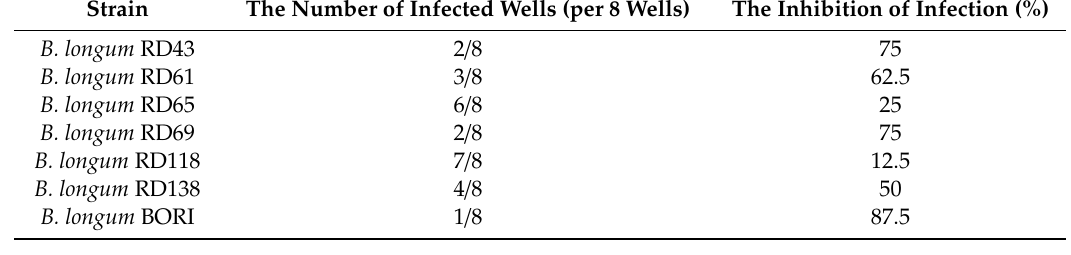
Table 1. The antiviral e ff ect of lyophilized Bifidobacterium 3 µ g / mL on rotavirus infected MA104 cells. Strain